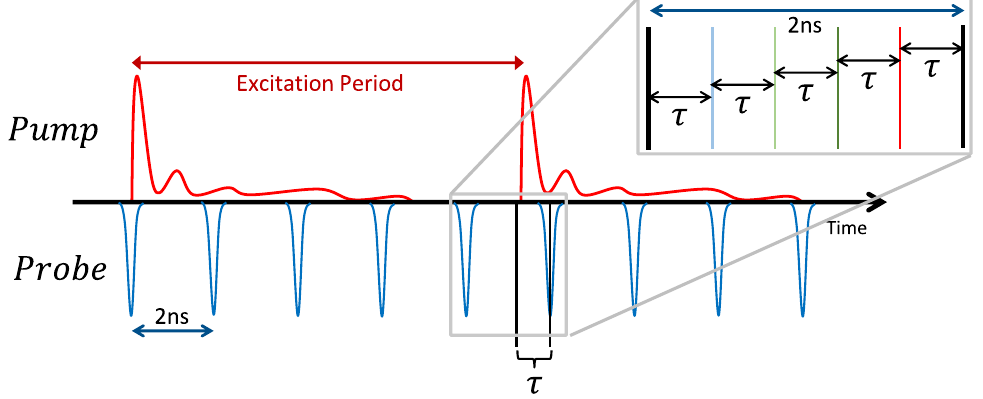
Figure 2. Illustration of the asynchronous pump-and-probe scheme used: The sample is probed every 2 ns by synchrotron flashes (probe period T S ). The pump period is a fractional multiple of the probe period, creating a shift of τ after each pump cycle between pump and probe. This delay adds up to the full 2 ns probe period after an integer number M of pump cycles (as shown in the inset), resulting in a time resolution of τ for the acquisition. In this example N = 24, M = 5, T P = 9.6 ns, τ = 0.4 ns.